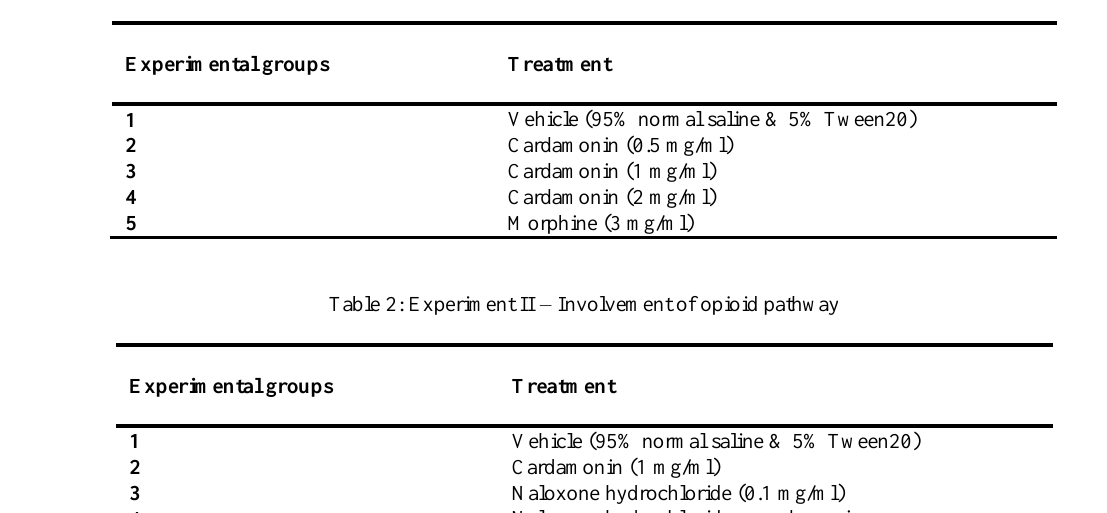
Table 1: Experiment I – CAPs inhibition by cardamonin